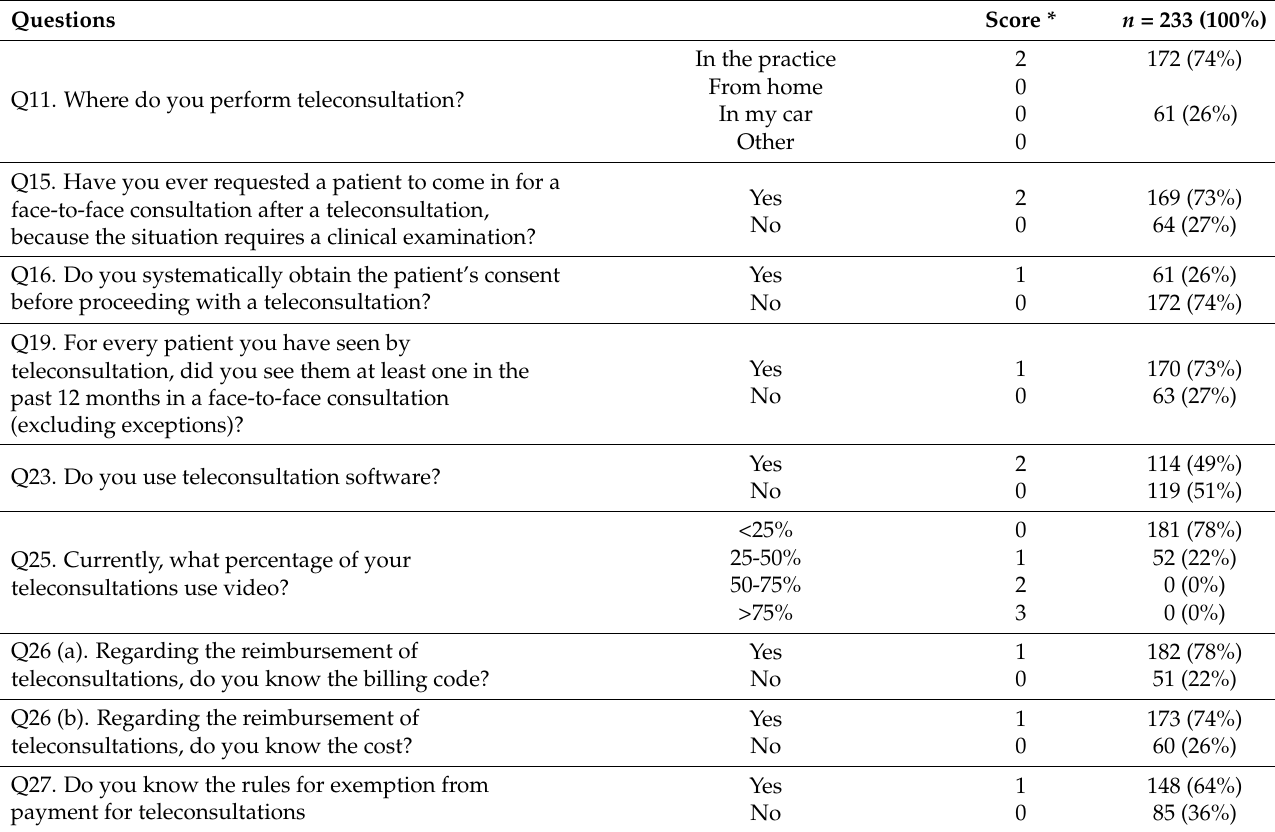
Table 1. Survey scores on telemedicine knowledge among general practitioners (GPs) in a region in France in